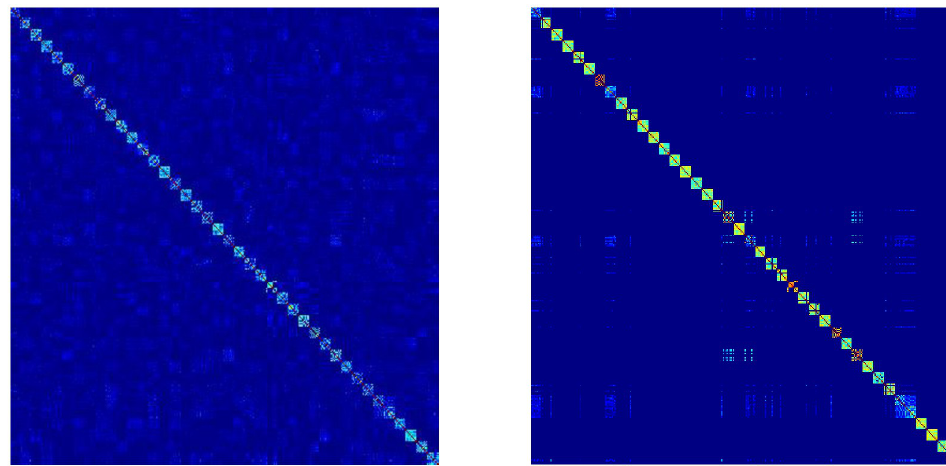
Fig 11. Visual analysis of unified matrices U 1 and U 2 on